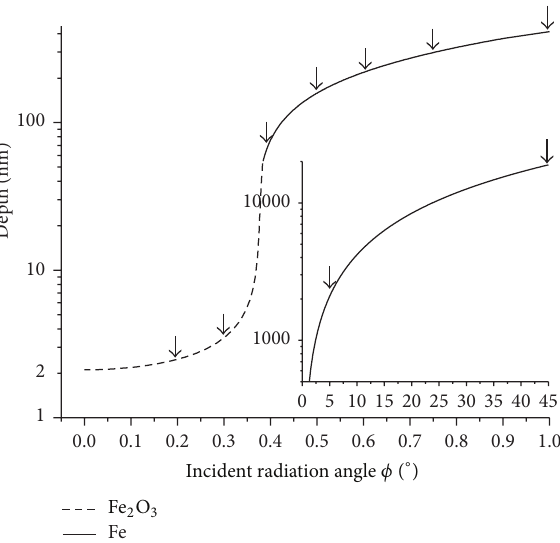
Figure 2: Calculated penetration depth (3) as a function of the incident radiation angle for sample A. Incident radiation energy 7072 eV. Irradiation angles are also plotted.